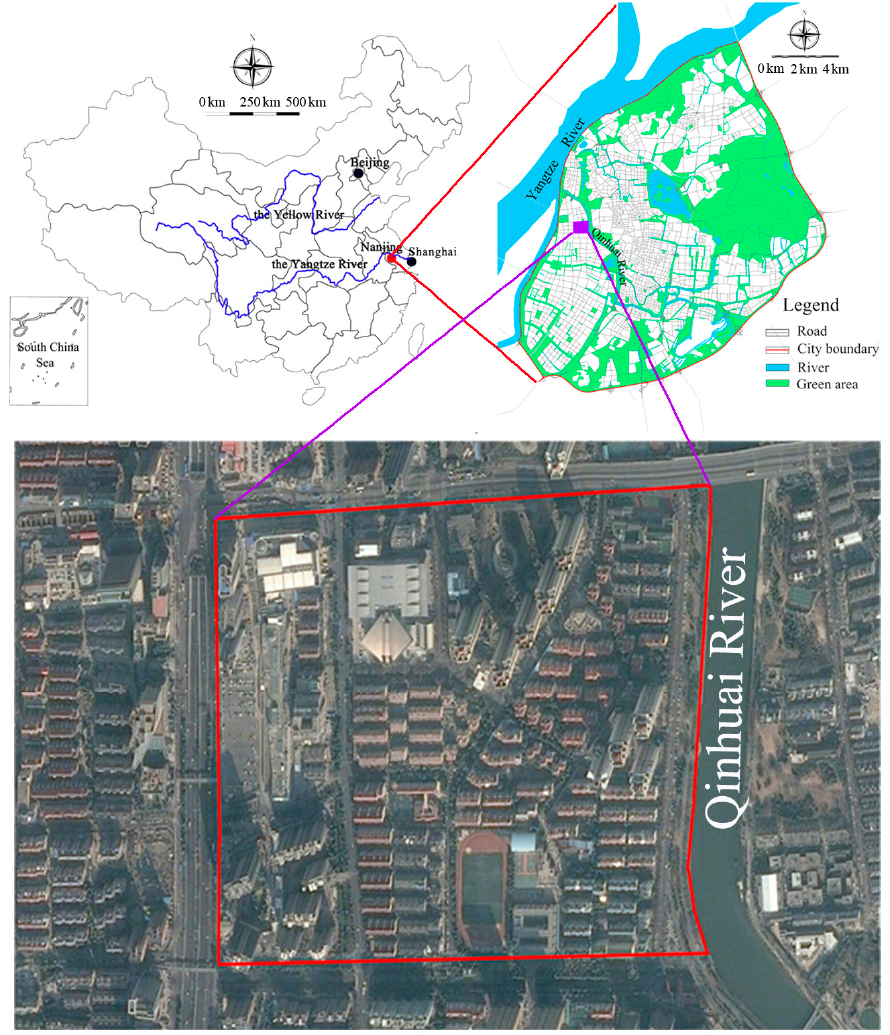
Figure 1. Study area of the residential block in Nanjing, China.